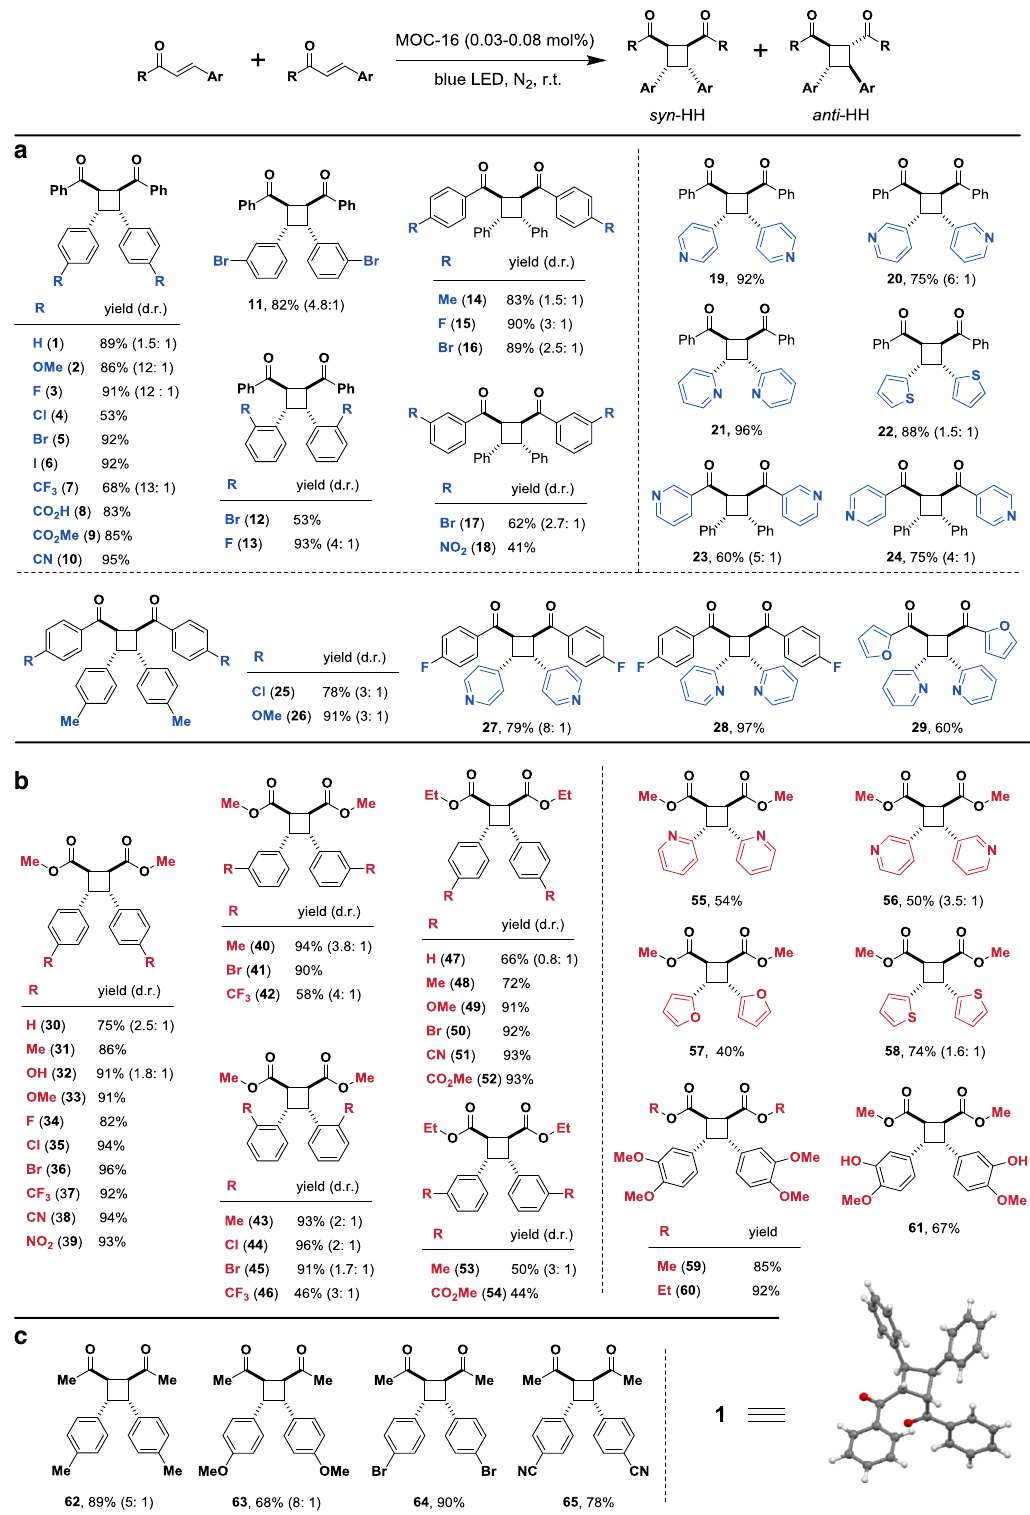
Fig. 2 Substrates scope of homocoupling [2 + 2] cycloadditions. Isolated yields are shown with d.r. in parentheses determined by 1 H NMR analyses. No d.r. value means excellent diastereoselectivity for the syn -HH isomer with the anti -HH isomer undetectable. The data are based on average of two runs. Substrates of a chalcone, b cinnamate, and c benzylideneacetone derivatives. LED light-emitting diode (450 nm); r.t. room temperature. The single-crystal structure of product 1 is